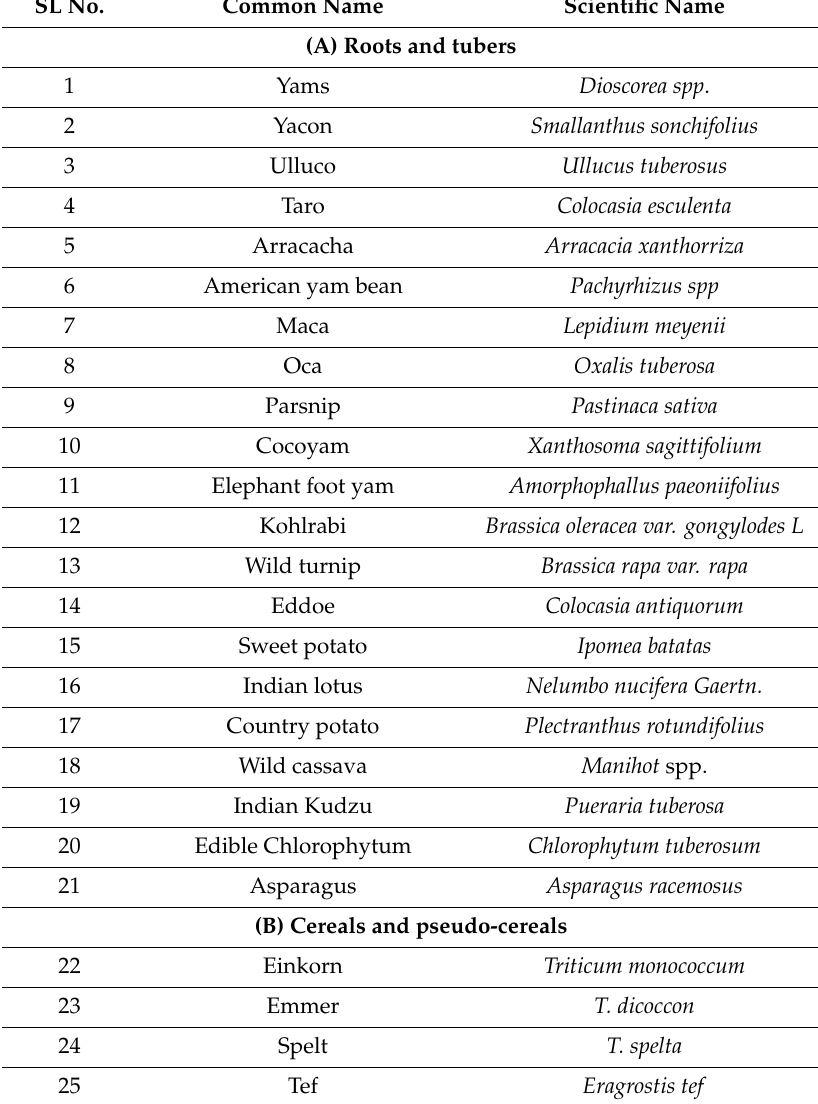
Table 1. An indicative list of promising neglected and underutilized species such as roots and tubers, cereals and pseudo-cereals, fruits and nuts, vegetables, legumes, spices, condiments, and food-dye agents for global food and nutritional security [10–14]. SL